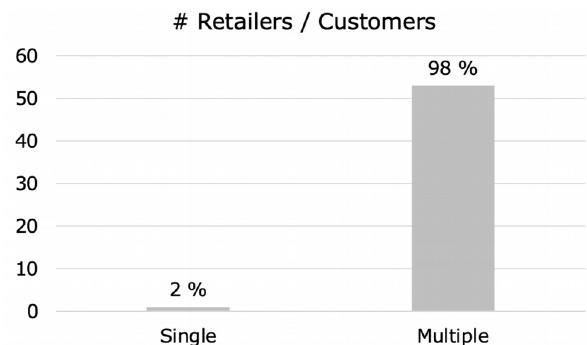
Figure 9. Statistics on supply chain structure: # retailers /